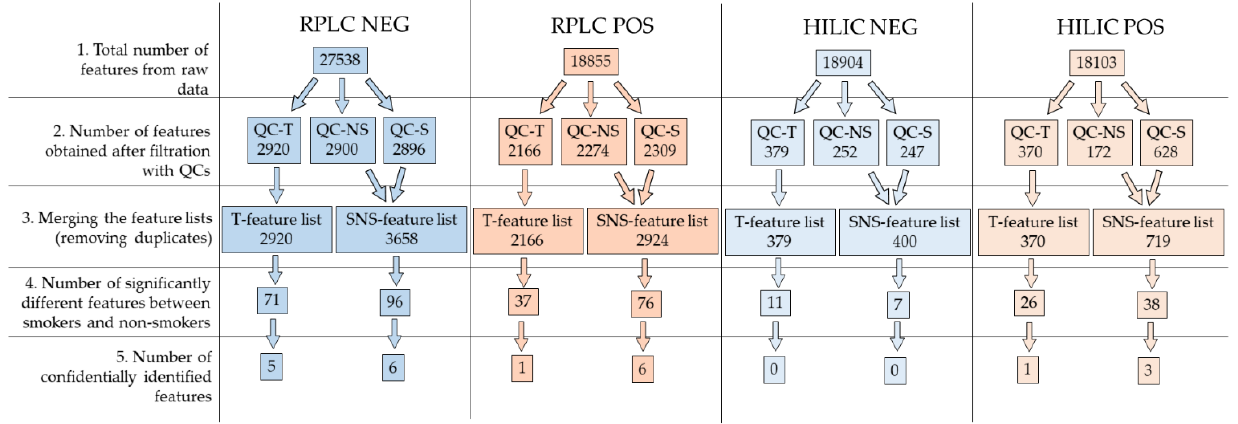
Figure 4. Summary of the data elaboration, for each of the four analytical conditions. 1: Total number of features extracted from raw data using the XCMS algorithm. 2: The total feature list was filtered by discarding featu res present in less than 50% of the QCs, those with a CV ≥ 30% among QCs, and with a blank contribution ≥ 10%. This procedure was performed separately using QC -T, QC-NS, and QC-S. 3: The feature lists obtained using QC-NS and QC-S were merged by eliminating dupli- cates, to yield the SNS-feature list. 4: A T -test was performed to find significantly different features between urine samples from smokers and non-smokers; this was performed separately with the T- feature list and with the SNS-feature list. 5: Number of features confidentially identified (level 1) with external analytical standards under the same analytical conditions. Table 1. List of confidentially identified features, for each chromatographic run: RPLC NEG (out of 98 significant features), RPLC POS (out of 76 significant features), and HILIC POS (out of 48 signif- icant features). No compounds were confidently identified in HILIC NEG (out of 12 significant fea- tures). For each feature, the mass-to-charge ( m/z ) ratio, retention time (RT), and CAS number are reported, along with the FDR p -value of the t -test, in which group of subjects the compound was higher (smokers, S, or non-smokers, NS), and in which feature lists that feature was present. RPLC NEG m/z